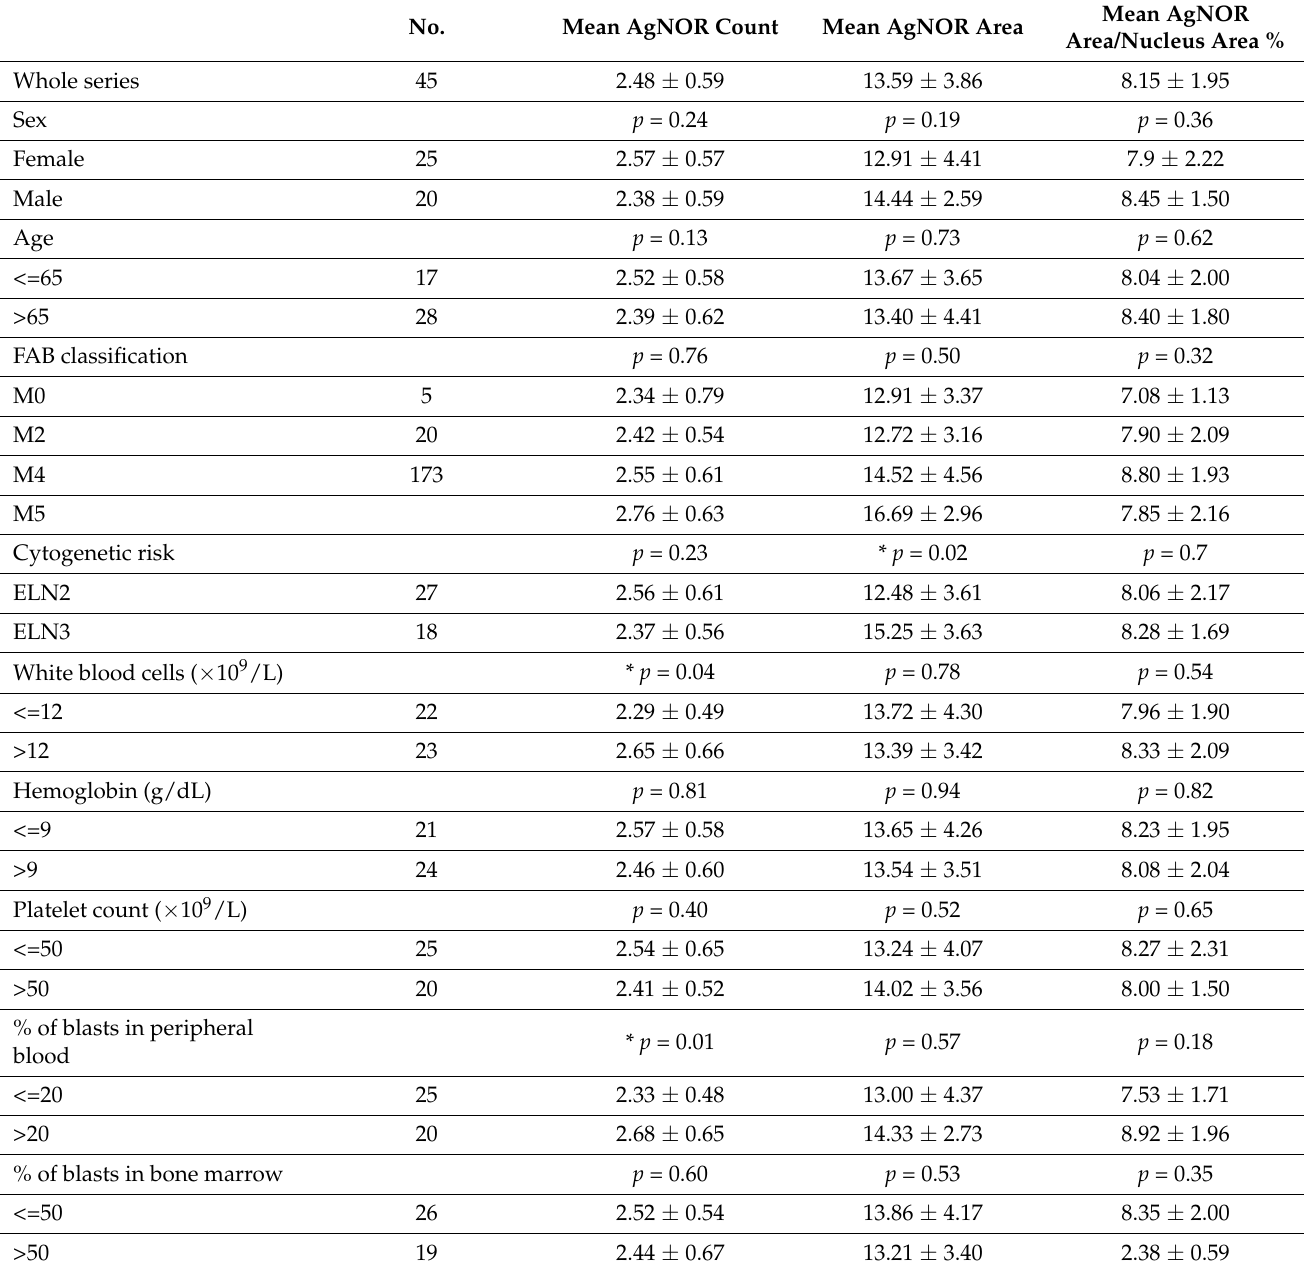
Table 2. Mean values of AgNOR indexes in the AML patient